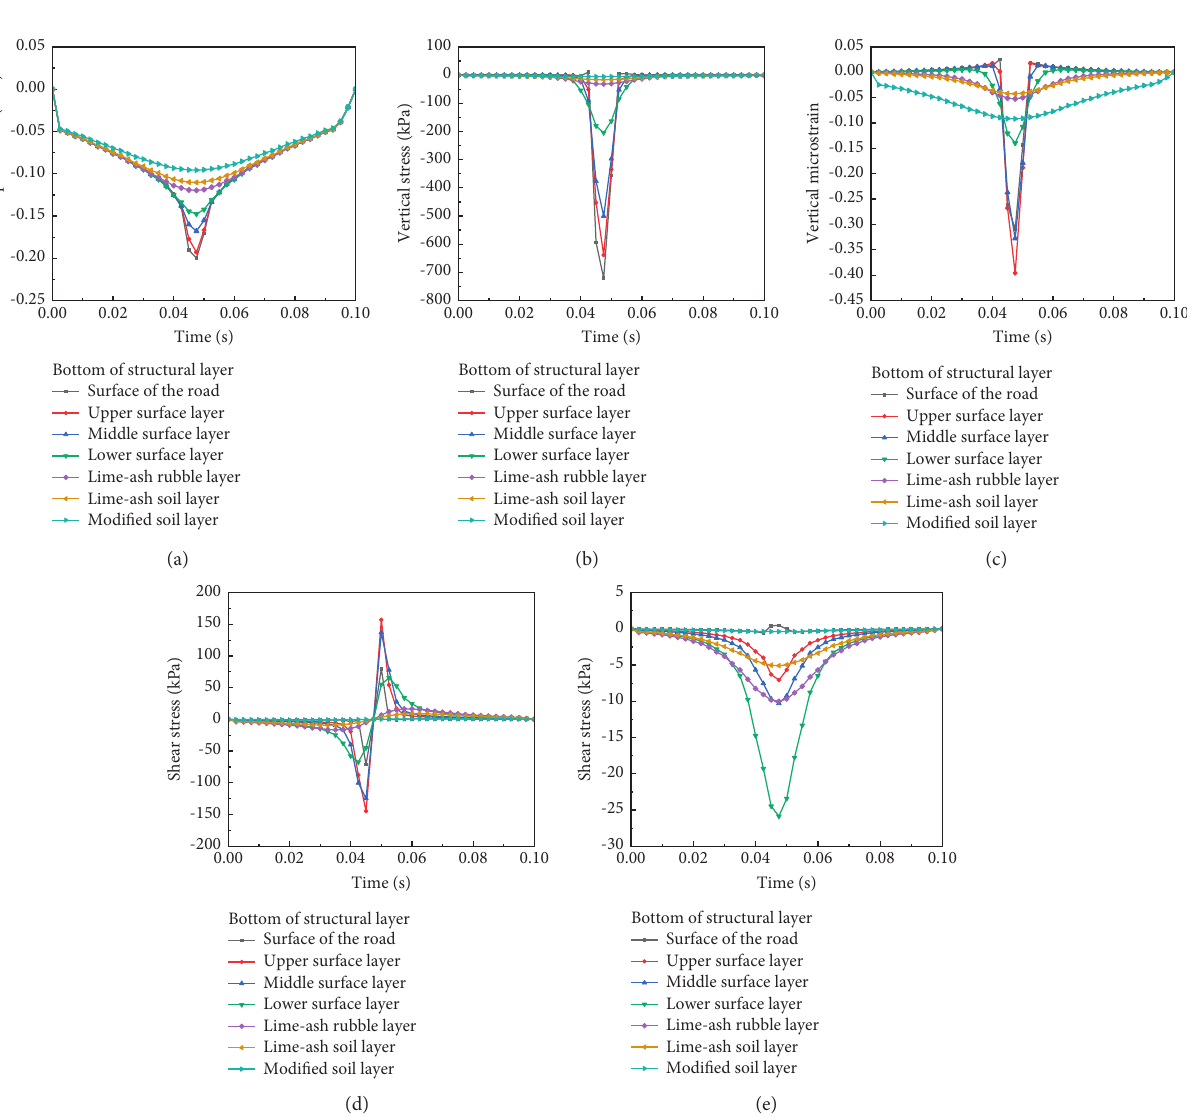
Figure 8: Time history curve of (a) vertical displacement, (b) vertical stress, (c) vertical micro strain, (d) longitudinal shear stress, and (e) transverse shear stress at each layer of structure